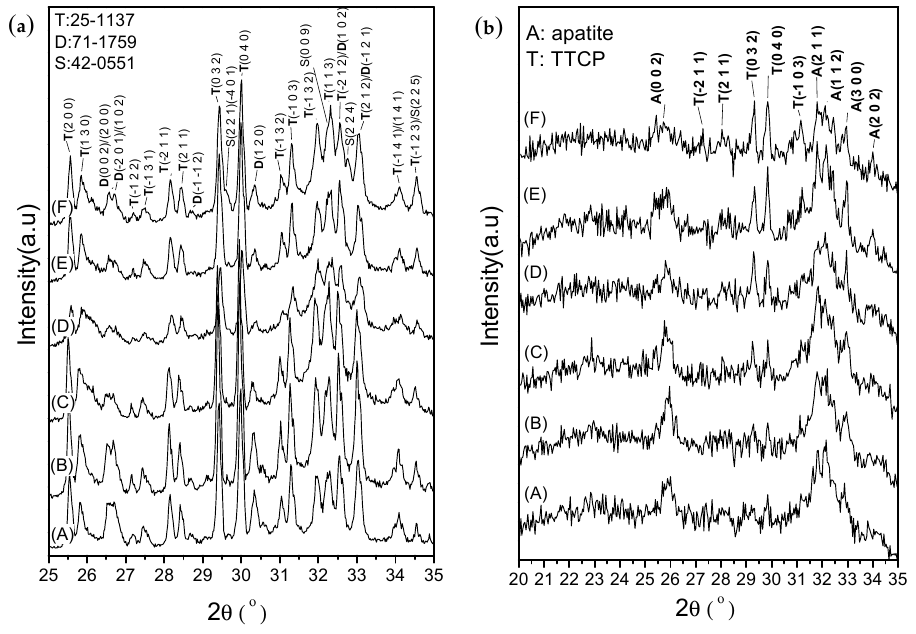
Figure 7. X-ray diffraction patterns of samples after setting for 1 h ( a ) and for 24 h ( b ). (A) CPC; (B) CPC/H2; (C) CPC/H2/CS5; (D) CPC/H2/CS5Z; (E) CPC/H2/CS10; (F) CPC/H2/CS10Z.